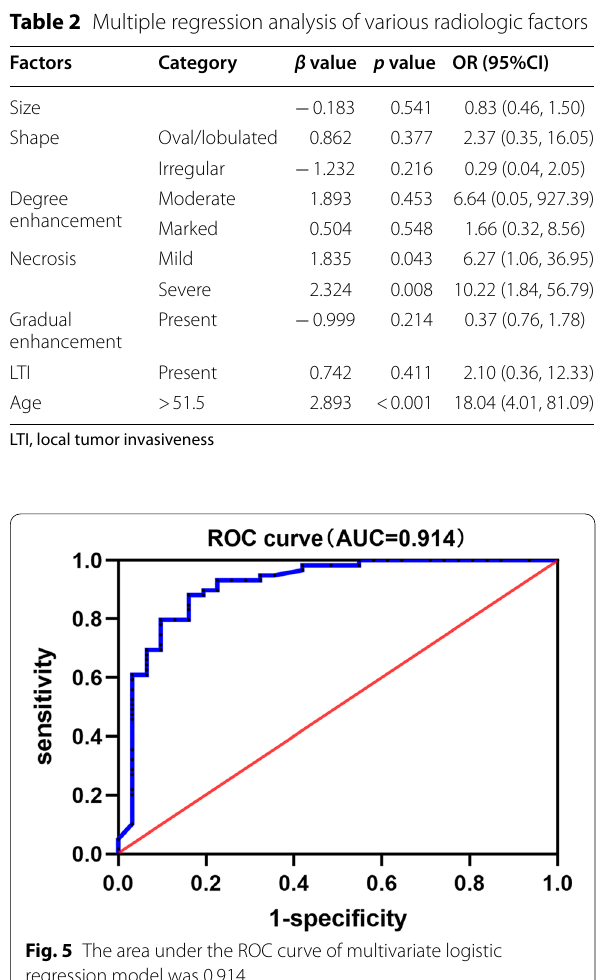
Table 2 Multiple regression analysis of various radiologic factors